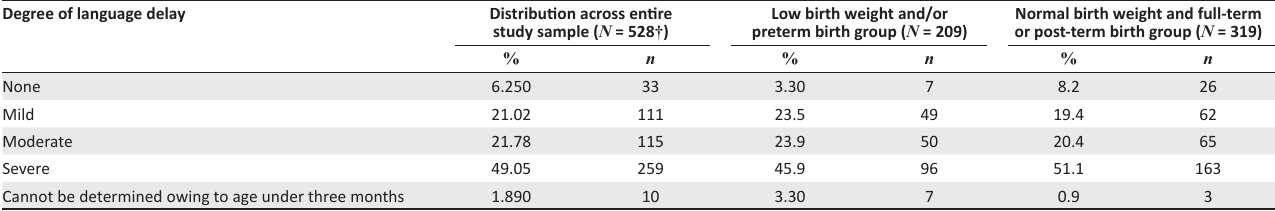
TABLE 4: Degrees of language delay across study sample. Degree of language delay